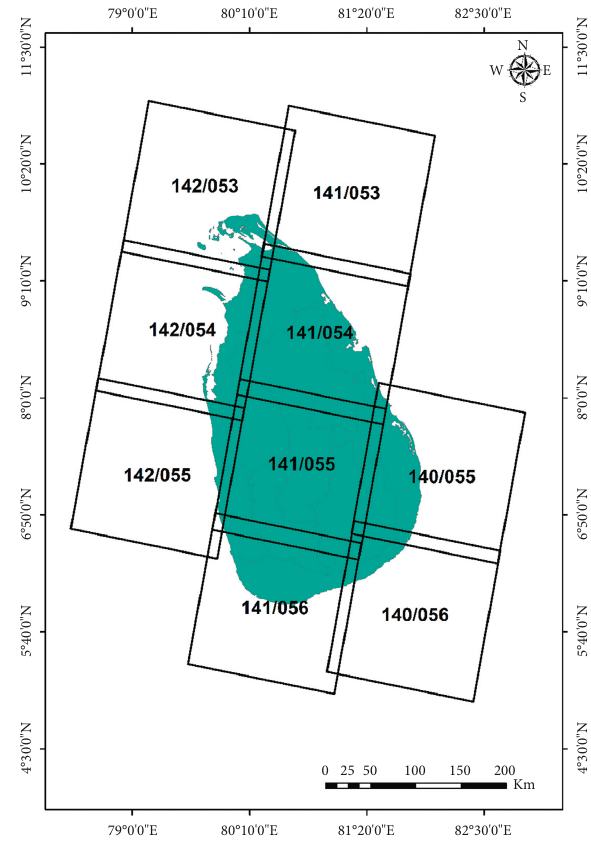
Figure 3: Landsat tiles arrangement of Sri